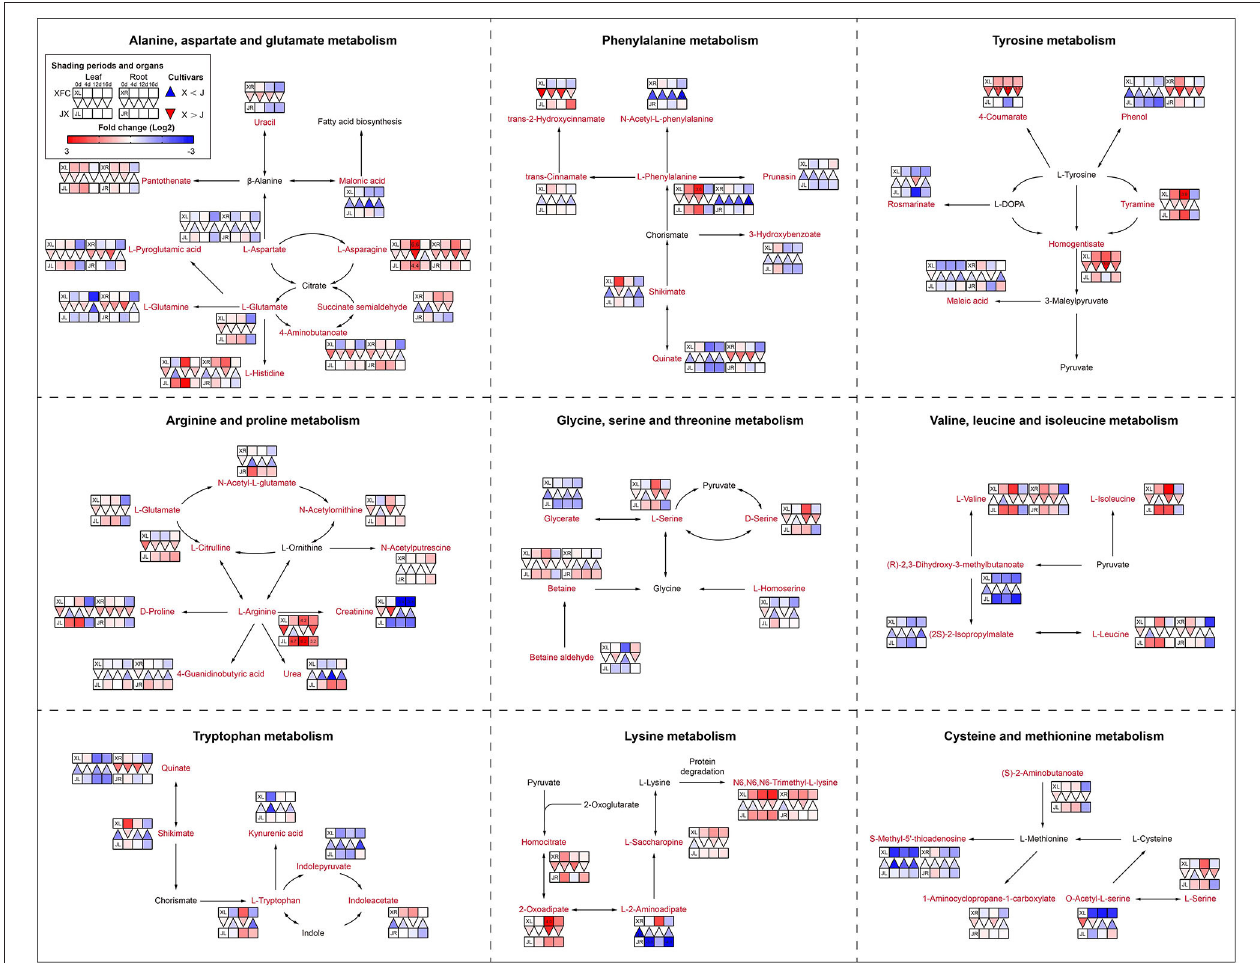
FIGURE 11 | The metabolite differences during amino acid metabolism in the two tea cultivars under different shading periods. The identified metabolites are marked with a red color. In the legend, the squares at two lines express the different cultivars, “Xiangfeicui” (XFC) and “Jinxuan” (JX). The squares at eight columns express the different shading periods. The squares in the left part represent the leaves and the right part represents the roots. Blue indicates relatively low and red indicates relatively high intensity. The red triangle indicates relatively higher intensity of metabolites in XFC (X) than in JX (J), and the inverted blue triangle indicates relatively lower intensity of metabolites in XFC (X) than in JX (J). The degree of change was described with the depth of color, and the depth of the colors is based on the log2-fold change value between the samples. XL, leaf of “Xiangfeicui”; XR, root of “Xiangfeicui”; JL, leaf of “Jinxuan”; JR, root of